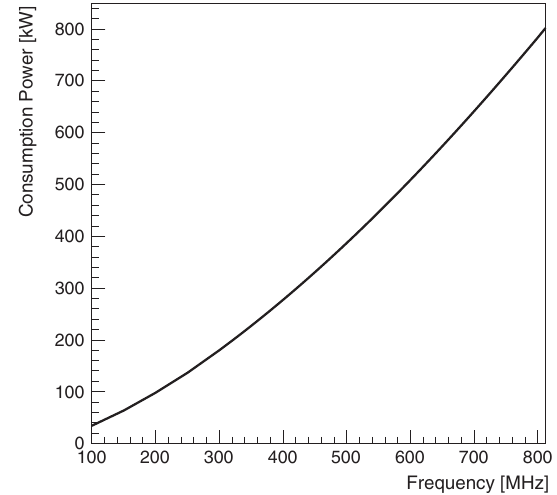
FIG. 1. The ohmic loss of Cu normal-conducting RFQ (NC- RFQ) as a function of the resonant frequency. The ohmic loss was evaluated by the lumped circuit model of a RFQ length and intervane voltage of 3.1 m and 80 kV, respectively, similar to those of J-PARC. The ohmic loss of NC-RFQ was calculated using Eq. (A3).